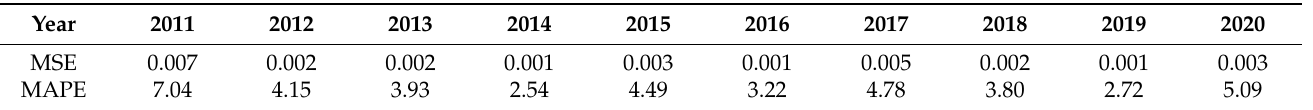
Table 4. Performance indices MSE and MAPE to evaluate the prediction effects of the proposed ANFIS model.